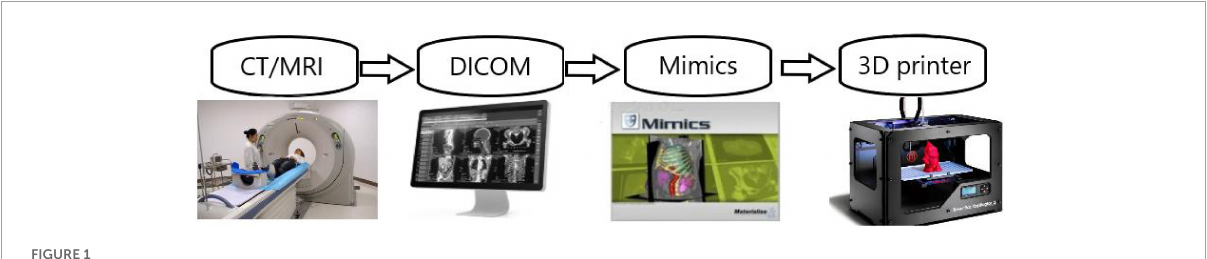
FIGURE1 The process of 3D printing